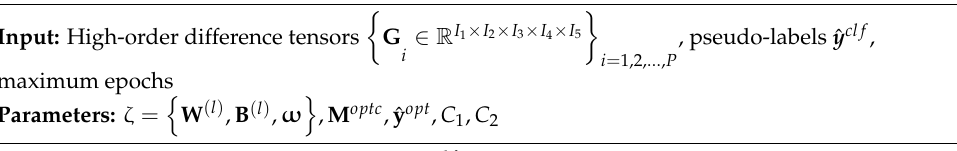
Figure 5. False-color composition of ( a , e ) Yancheng, ( b , f ) Bay Area, ( c , g ) River, and ( d , h ) Hermiston city. Algorithm 2. Pseudocode of the proposed STT for multitemporal HSI change